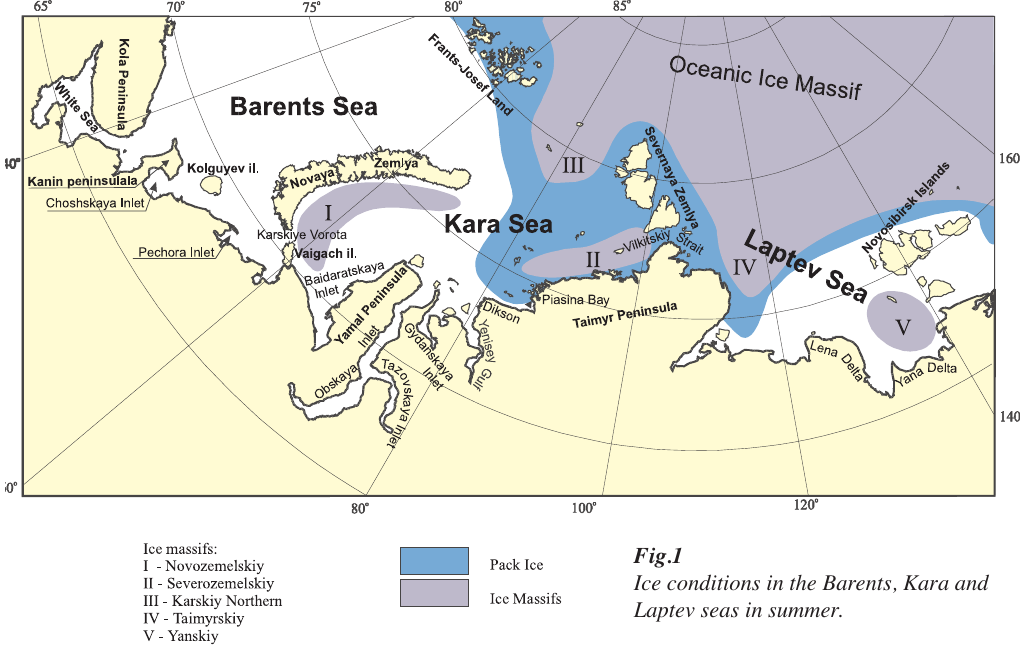
Ice conditions in the Barents, Kara and Laptev seas in